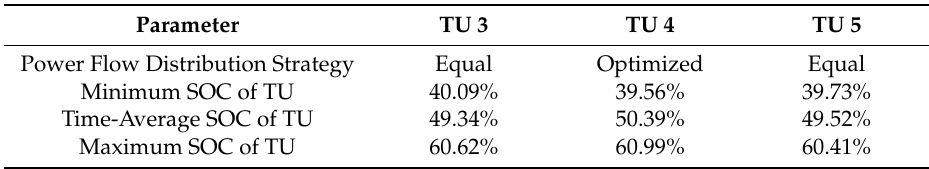
Table 7. Field-test results for the State of Charge (SOC) in the Technical Unit (TU) with equal Power Flow Distribution Strategy (PFDS) (TU 3 and TU 5) and optimized PFDS (TU 4) for the extended testing timeframe of 14 days in August 2017.